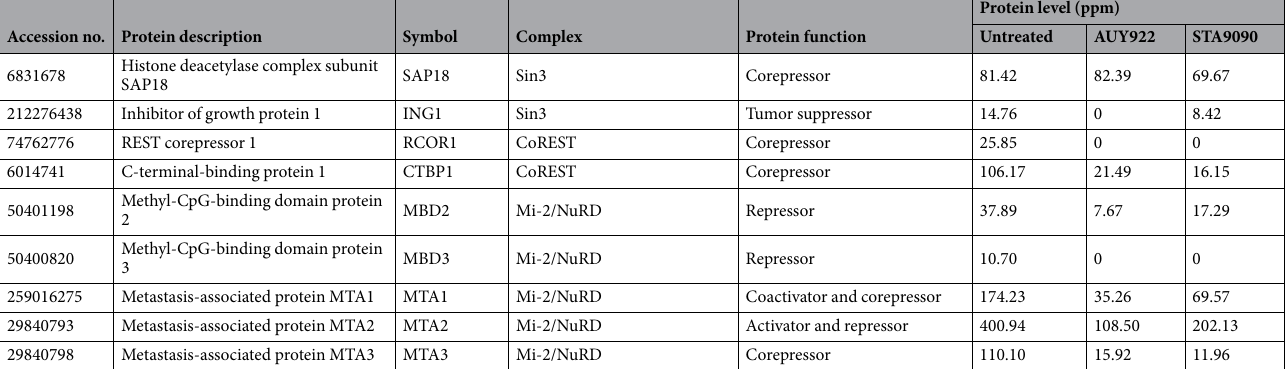
Table 4. Selected differentially expressed chromatin modifying enzymes and proteins in bladder cancer 5637 cells in response to treatment with the heat shock protein 90 inhibitors AUY922 and ganetespib